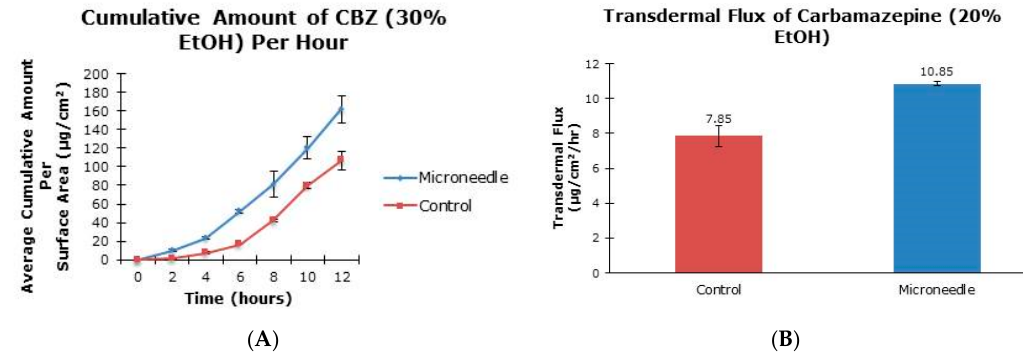
Figure 5. In vitro cumulative amount versus time curve ( A ) and transdermal flux ( B ) of carbamazepine in 30% ethanol across untreated and microneedle-treated (500 µm needle length) porcine ear skin over 12 h.